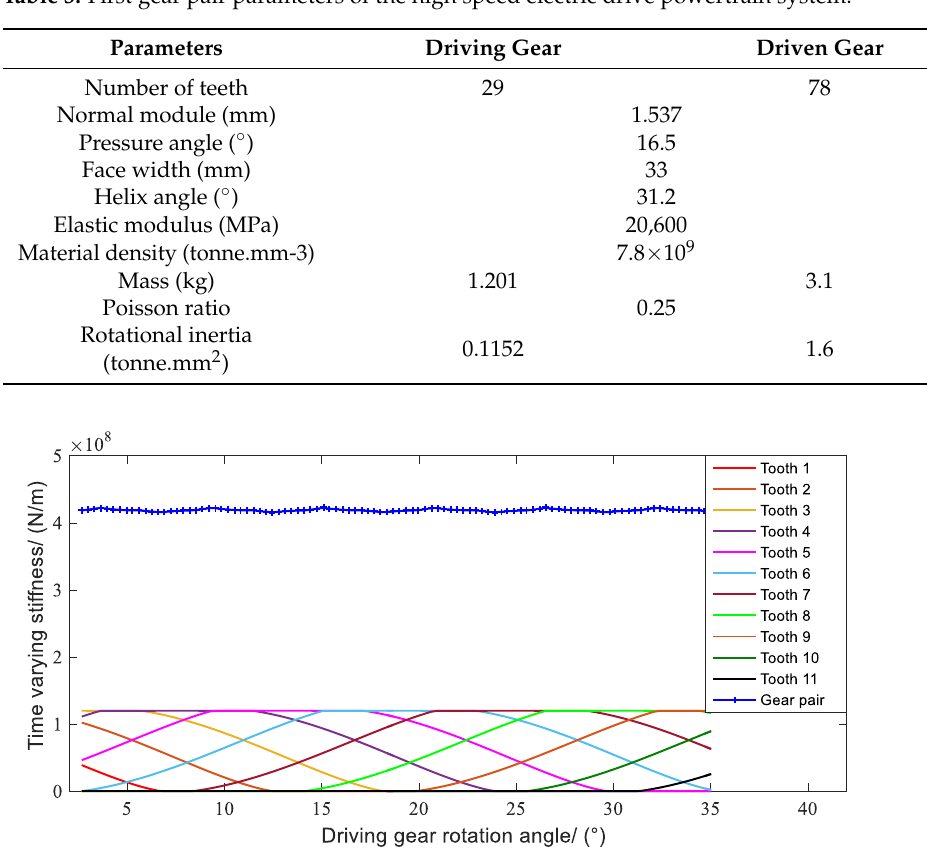
Table 3. First gear pair parameters of the high speed electric drive powertrain system.